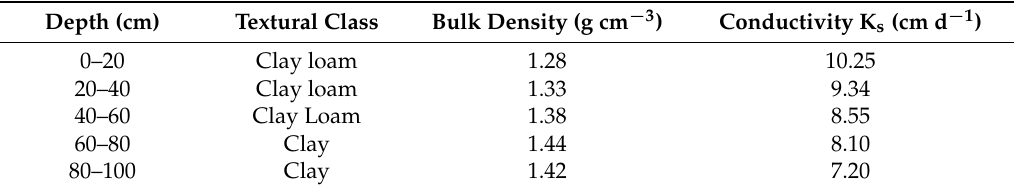
Table 1. Physical properties of the paddy soil in the experimental field.